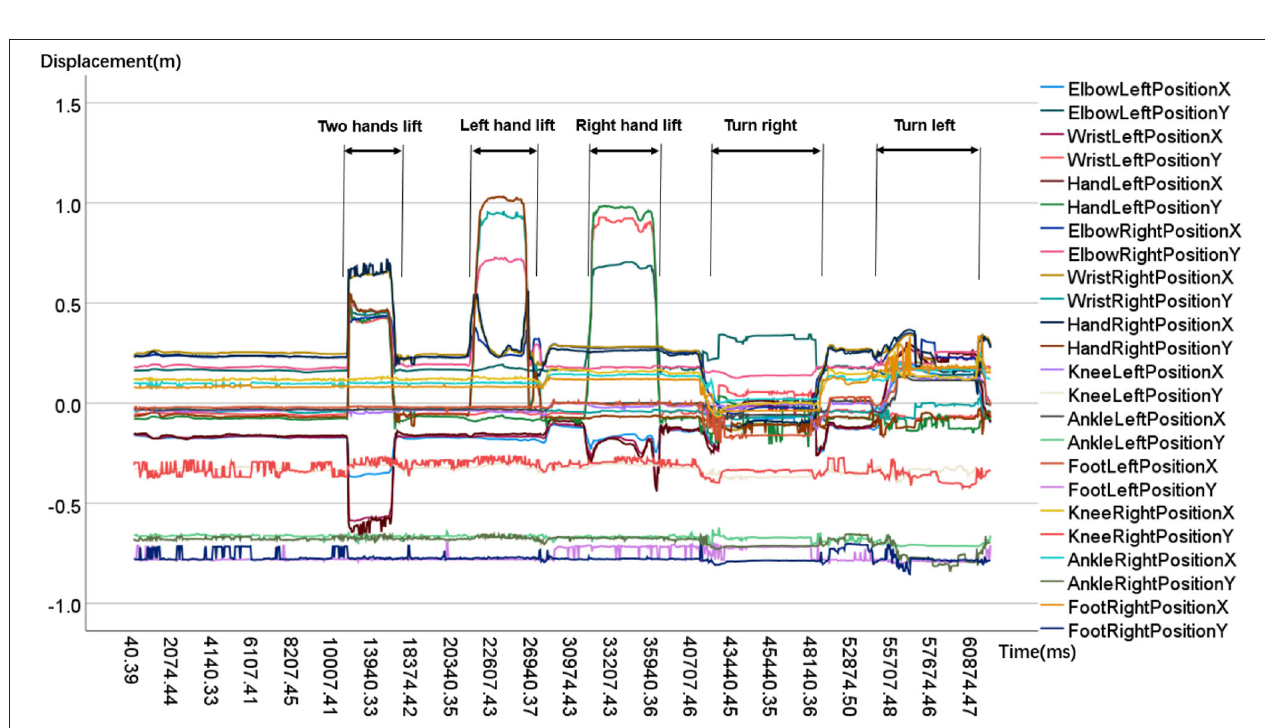
FIGURE 4 | Time sequences of partial body joints. From the sample’s key joints kinematic features, Upper body joints’ movement range like hand, elbow is apparently bigger than lower body joints’ like foot, ankle.